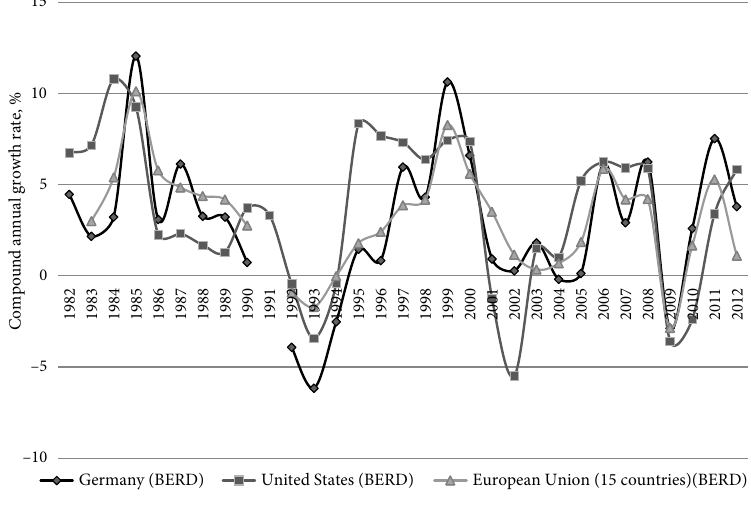
Fig. 8. The impact of the business cycle on innovations BERD (Business Enterprise Expenditure on R&D), yearly growth rates Source : Authors’ calculations based on the OECD data